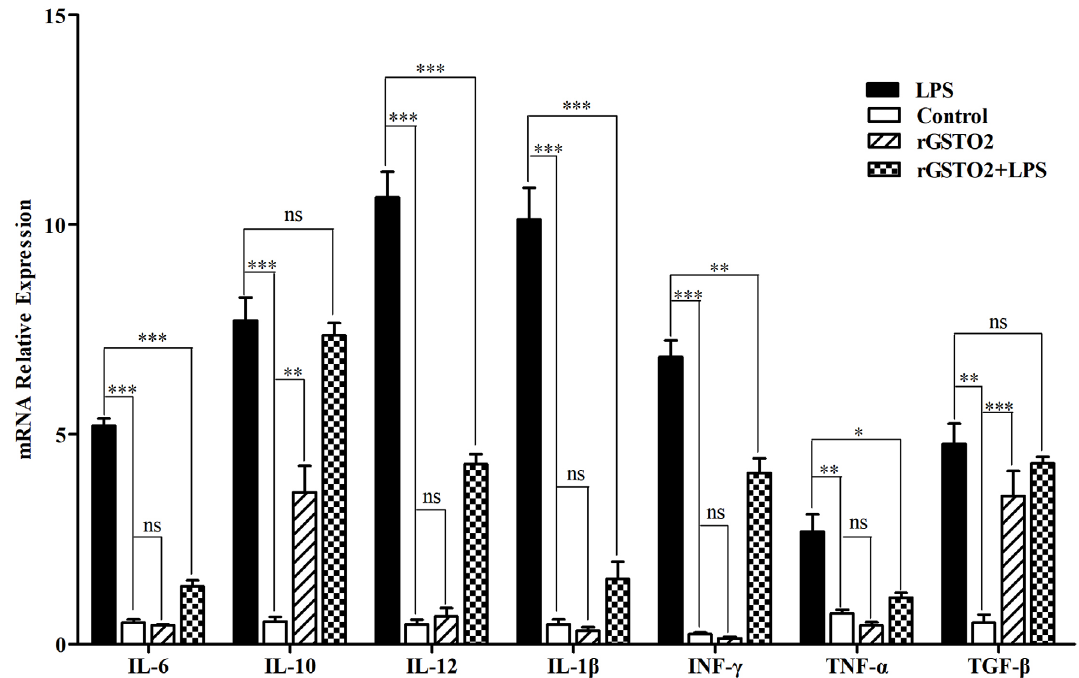
Figure 7. Analysis of the mRNA expression levels of cytokines in RAW264.7 macrophages stimulatd by rGSTO2 protein. Total RNA was extracted from macrophages with rGSTO2 alone or co-incubated with LPS for 24 h, then the mRNA expressions of IL-6, IL-10, Il-12, IL-1 b , INF- c , TNF- a and TGF- b were detected by real-time PCR, respectively. The signi fi cance level was set at * p < 0.05, ** p < 0.01 and *** p < 0.001 as compared to the control group. All data were expressed as means ± SD ( n =